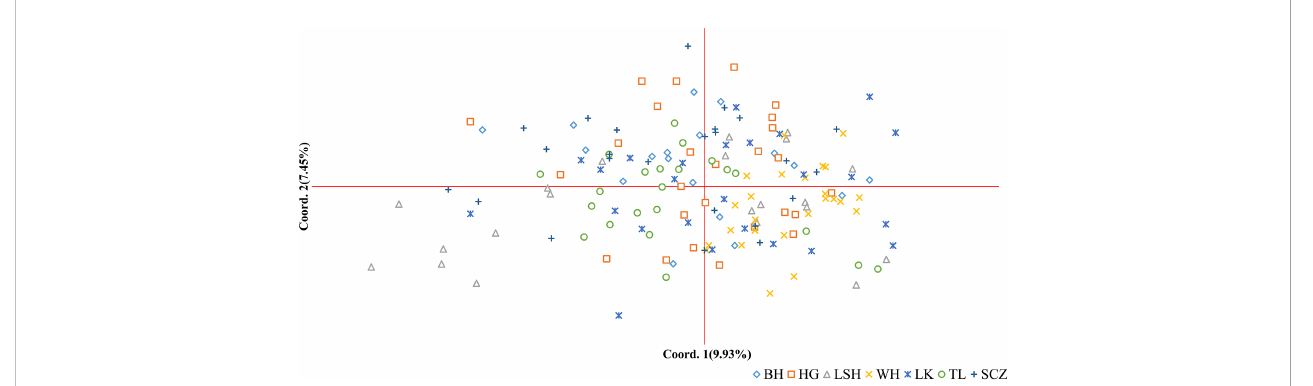
FIGURE 4 Principal coordinates analysis (PCoA) of Korean pine clones. (BH, Bohai; HG, Hegang; LSH, Lushuihe; WH, Weihe; LK, Linkou; TL, Tieli; SCZ, Sanchazi).